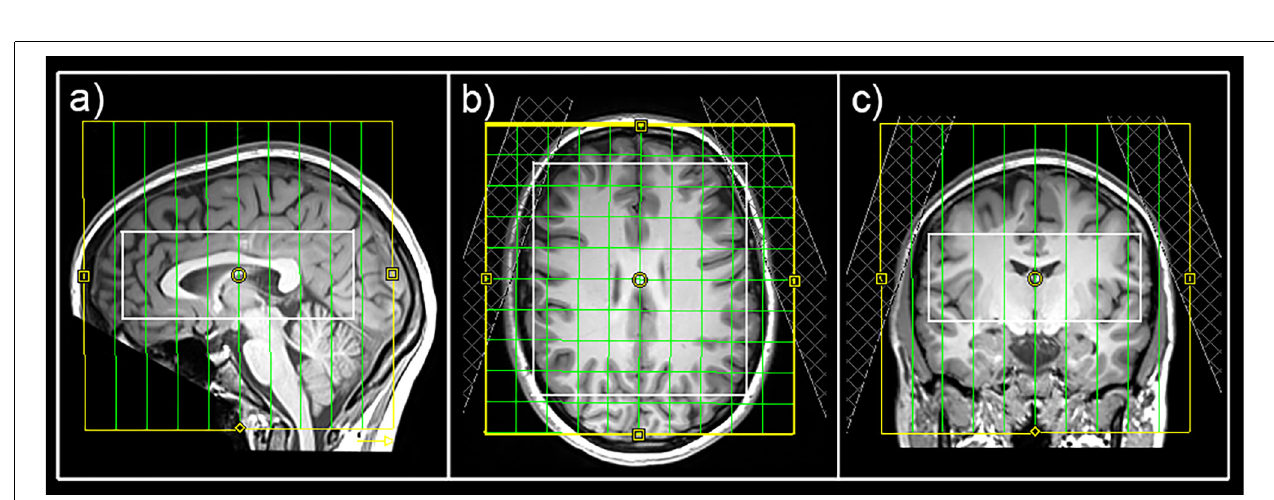
FIGURE 2 | Placement of the field of view (yellow), volume of interest (white), and tissue separation slaps in sagittal (A) , horizontal (B) , and coronal (C) views.